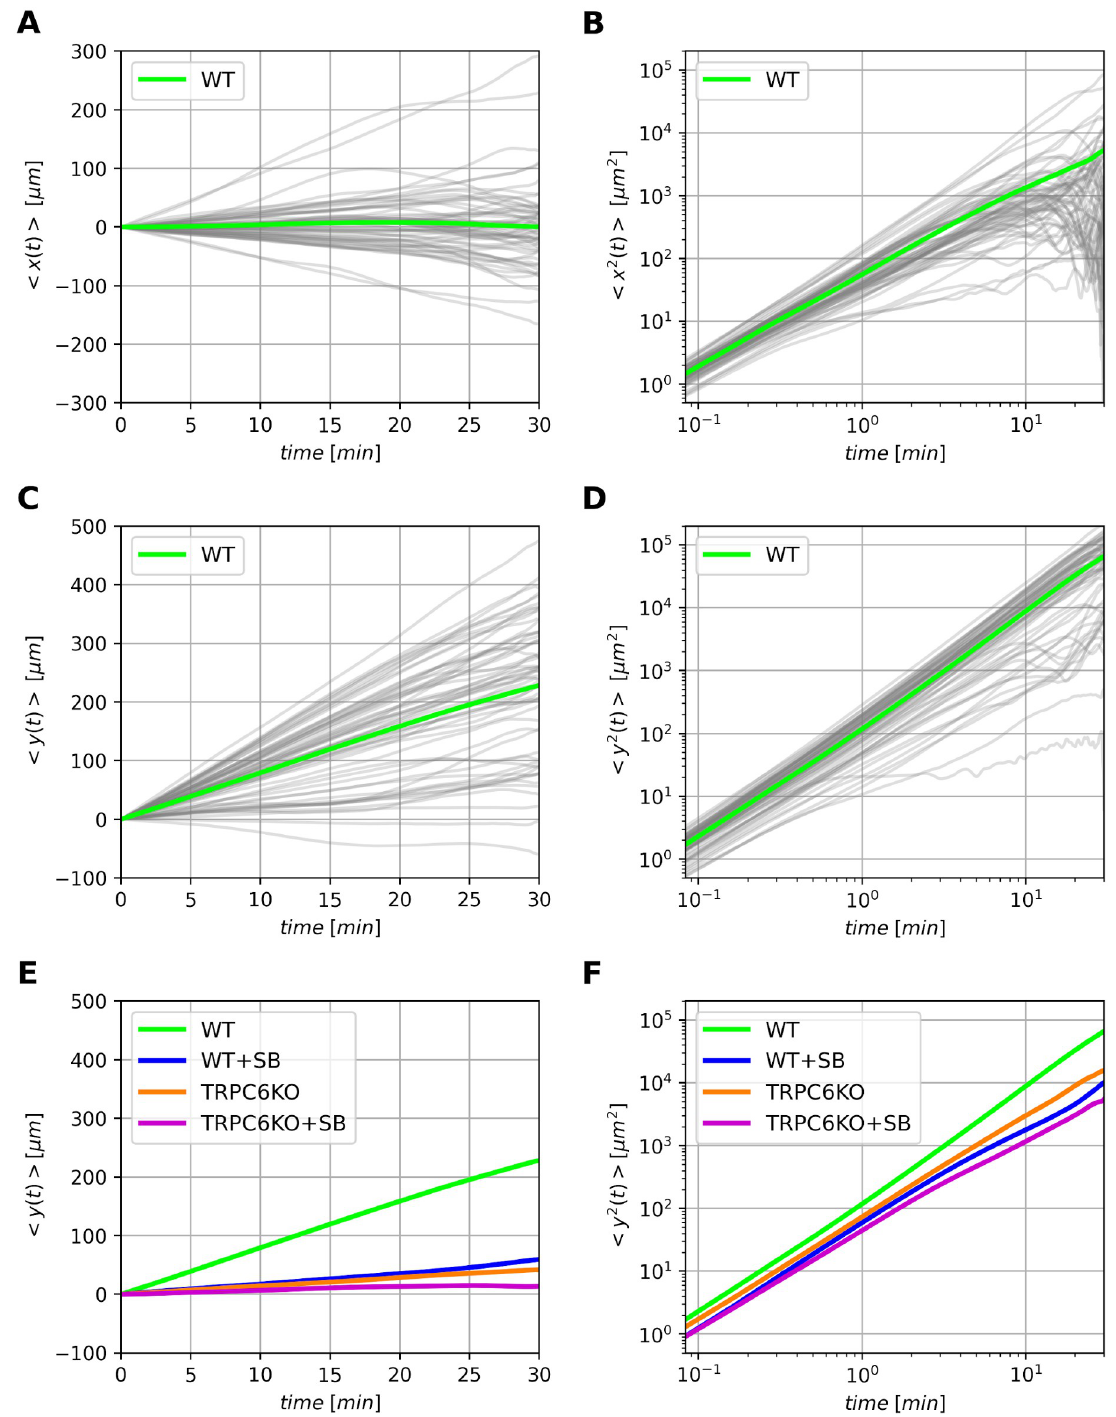
Fig 2. Overview of the first and second moments. (A), (B) and (C), (D) show the first and second moments of wildtype neutrophils with respect to x - and y -direction, respectively. Thin grey lines indicate time-averaged moments of single cells according to Eqs 16 and 17. The thick green lines show the time-ensemble-average of the corresponding moment according to Eqs 18 and 19. (E) compares the mean first moment of different experimental conditions with murine neutrophils. (F) shows the differences of the second moments, i.e. the mean squared displacement for murine